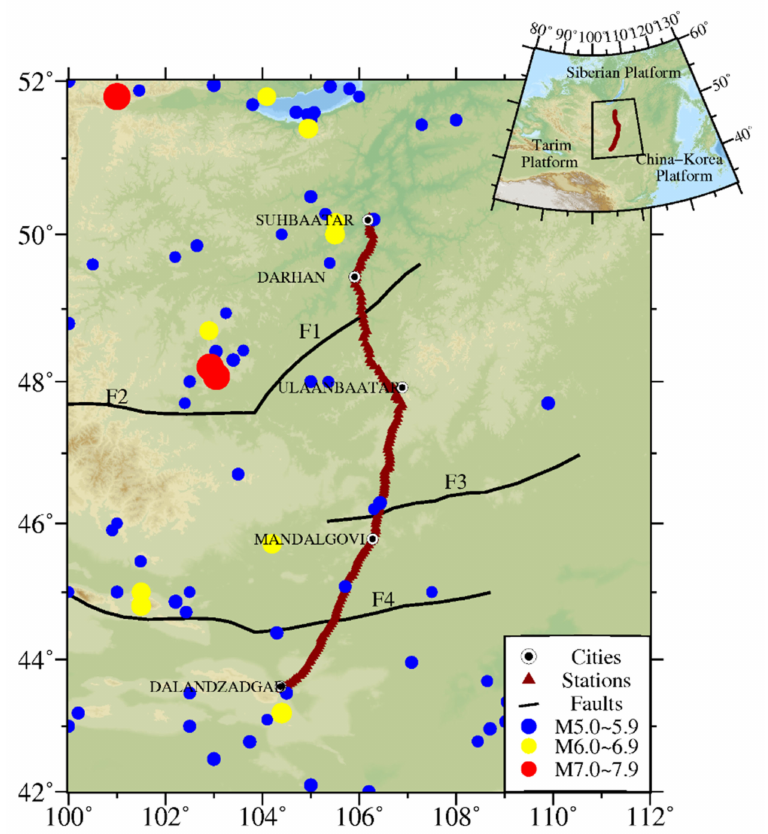
Figure 1. Geomagnetic stations of the SD profile, seismic activity, and fault distribution in Mon- golia. F1 is the Erhun River fault, F2 is the Khangai fault, F3 is the Hanbogdor fault and F4 is the Wenduerhile